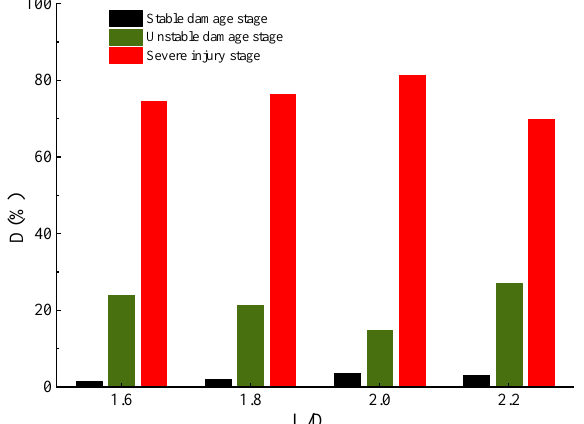
Figure 11. Analysis of damage stages of samples with different height-to-diameter ratios. The damage of samples with different height–diameter ratios has specific differences.